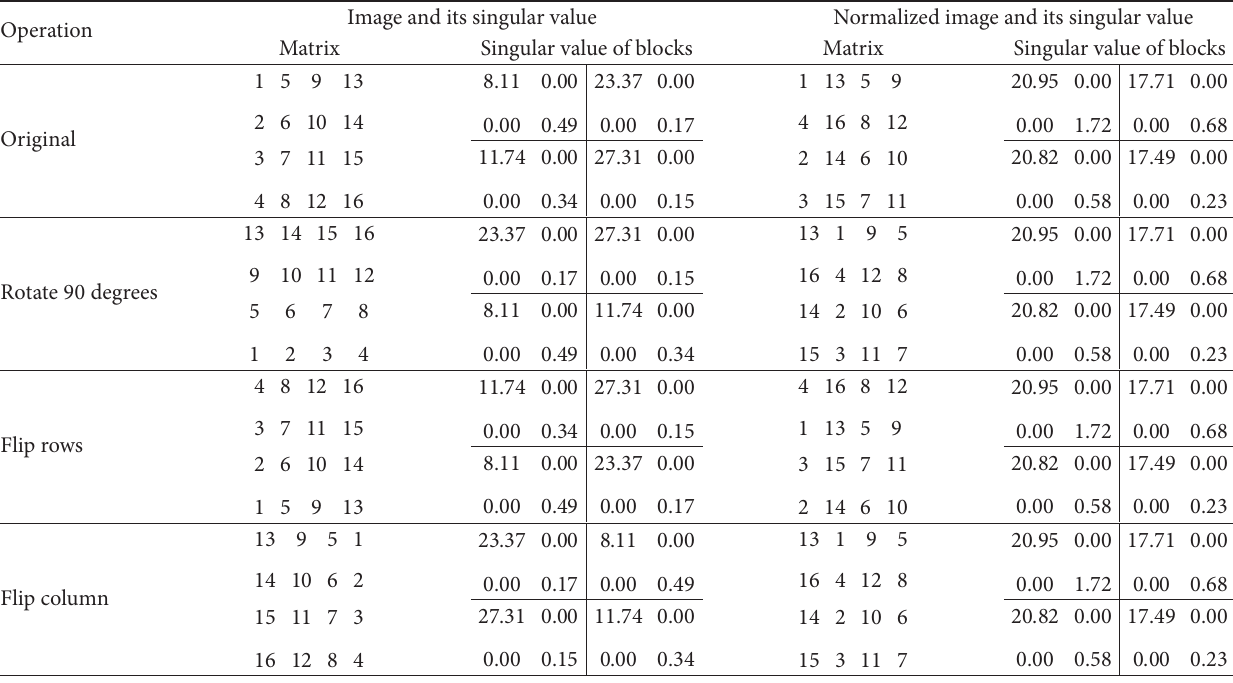
Table 1: Illustration of invariant features of the redistributed